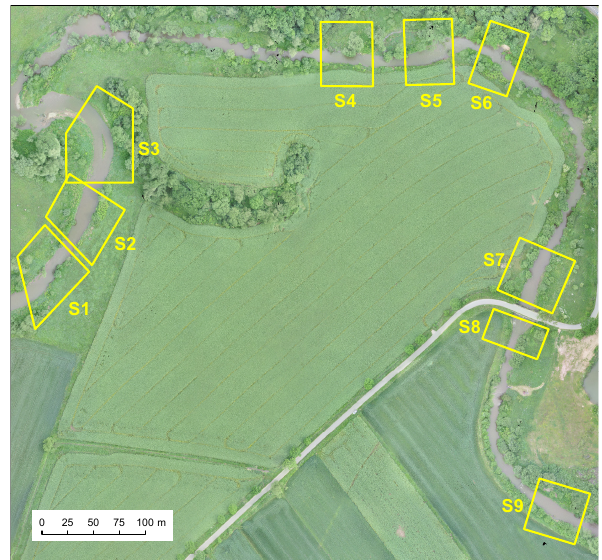
Figure 3. Study sites on the ´Scinawka river in Gorzuchów. Numbers in site codes increase in a downstream